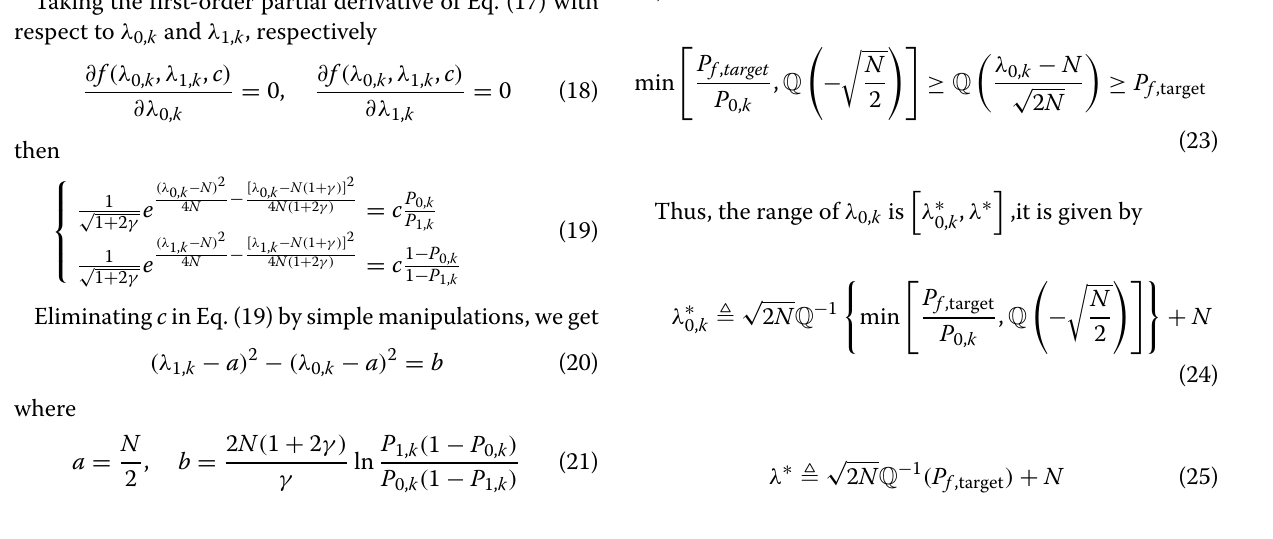
and λ ∗ with respect to each 0, k 1, k